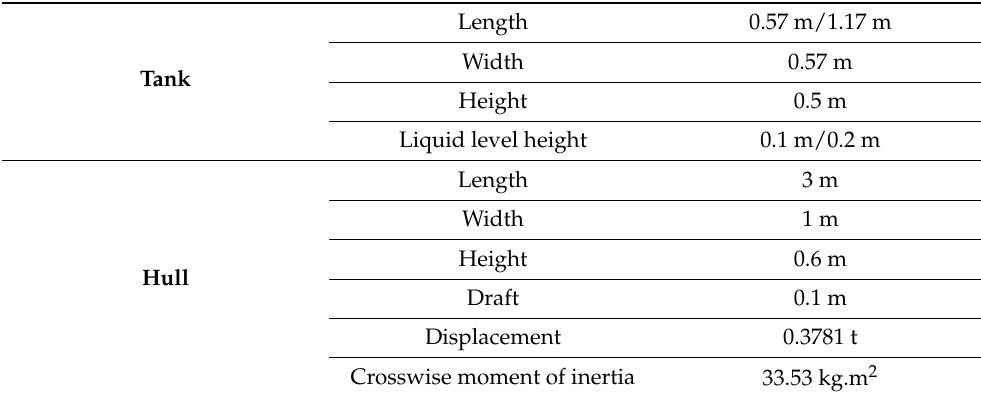
Table 1. The general